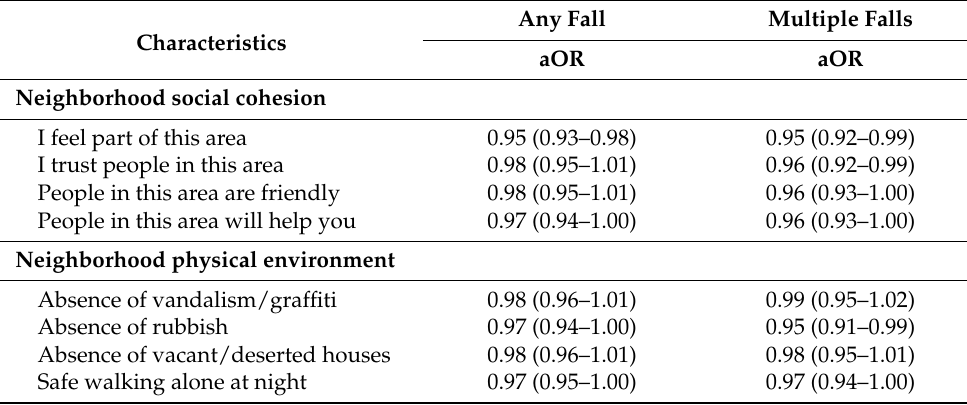
Table 4. Neighborhood characteristics and adjusted odds of falls using mixed-effect logistic regression models (robust variance estimation), n =